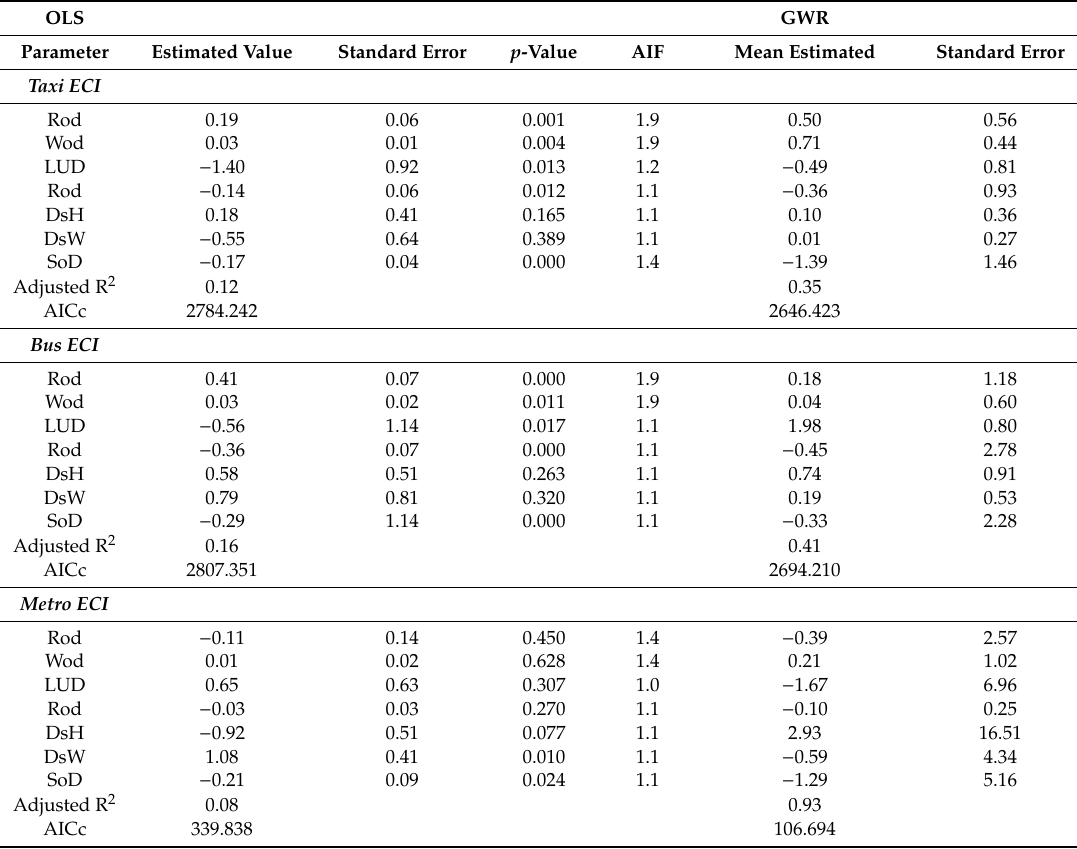
Table 4. Results of ordinary least-squares (OLS)-based and geographically weighted regression (GWR)-based